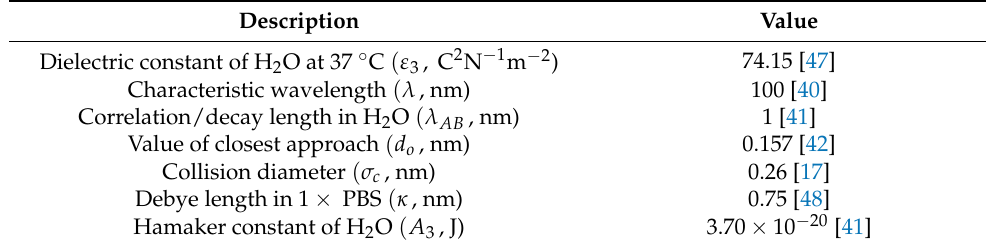
Table 6. Constants used to determine Gibbs interaction energies from extended DLVO theory.